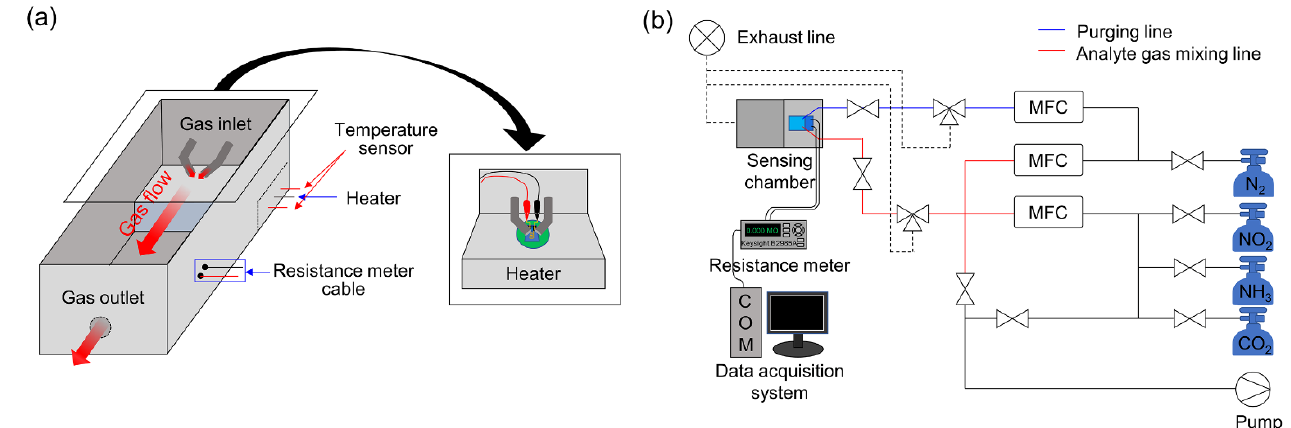
Figure 1. Schematic of a dynamic gas-sensing testbed developed in this work: ( a ) Gas-sensing test chamber with heating stage and electrical connection. ( b ) Overall system configuration showing the analyte and purge gas flow direction.